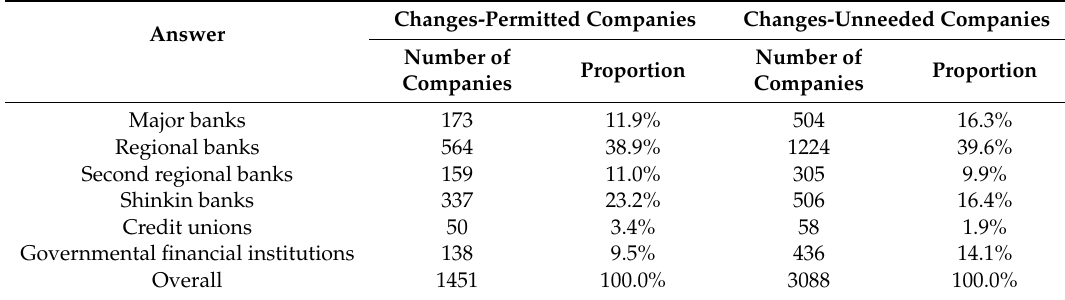
Table 8. The types of “main banks” separated by companies that did and did not receive loan condition changes. 1